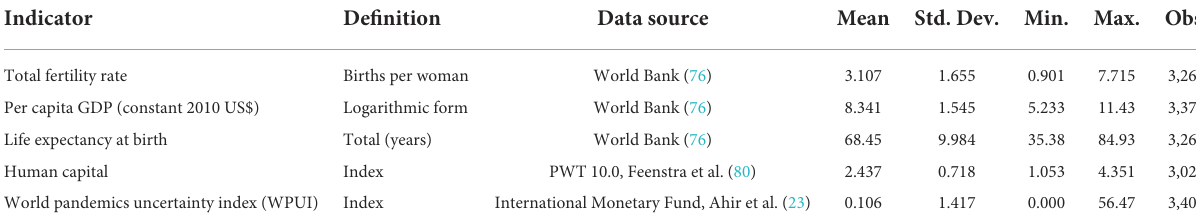
TABLE 1 Descriptive statistics.